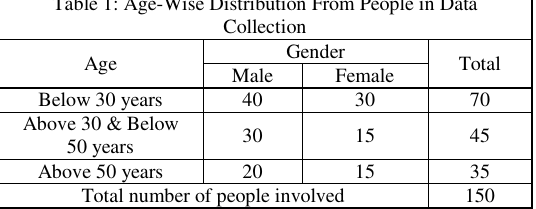
Table 1: Age-Wise Distribution From People in Data Collection